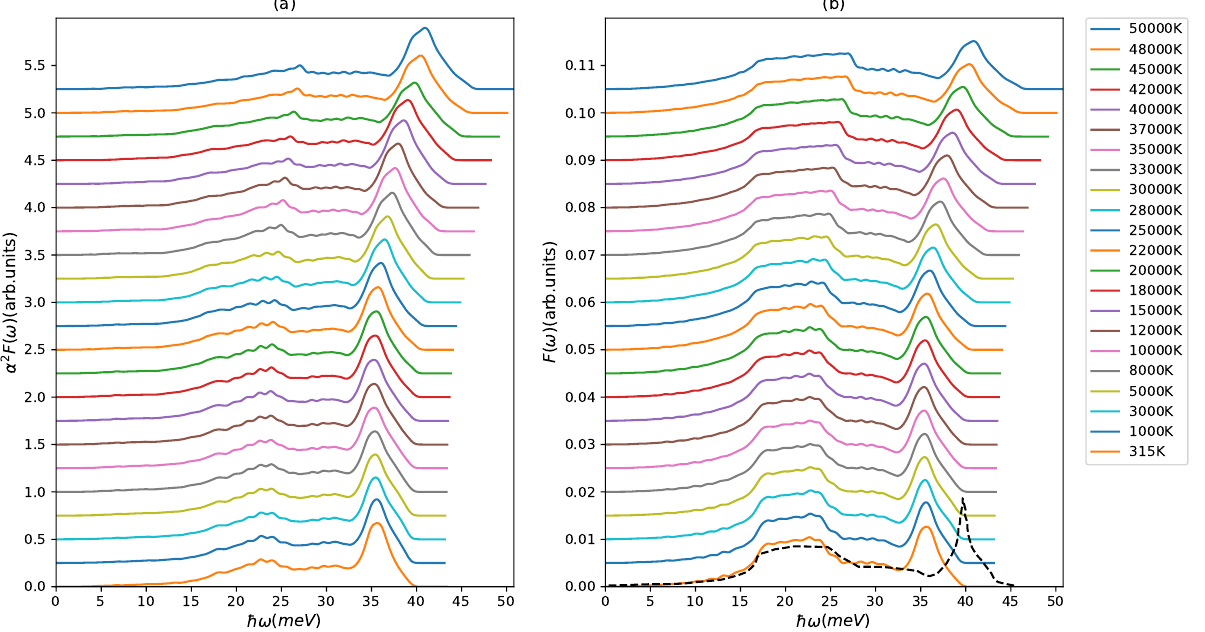
Figure 1. ( a ) Eliashberg function α 2 F ( ω ) and ( b ) phonon density of states F ( ω ) of aluminum at different electron temperatures (shifted along the y-axis for better visibility). The dashed black line is the low temperature result of Brown et al.